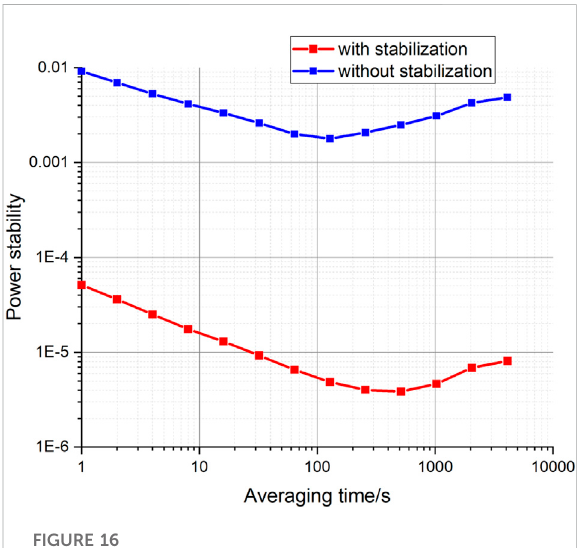
FIGURE 16 The intensity stability of the monitored laser with and without